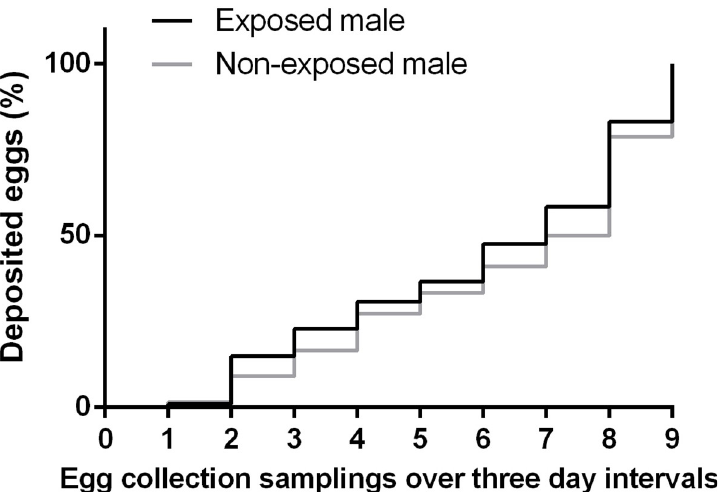
Fig 3. Temporal patterns of egg-laying by females mated to males exposed or non-exposed to guava volatiles. The cumulative percentage of eggs laid (y axis) across 9 egg collection samplings (x axis) is presented for the two types of females. Each sampling was carried out every three days.